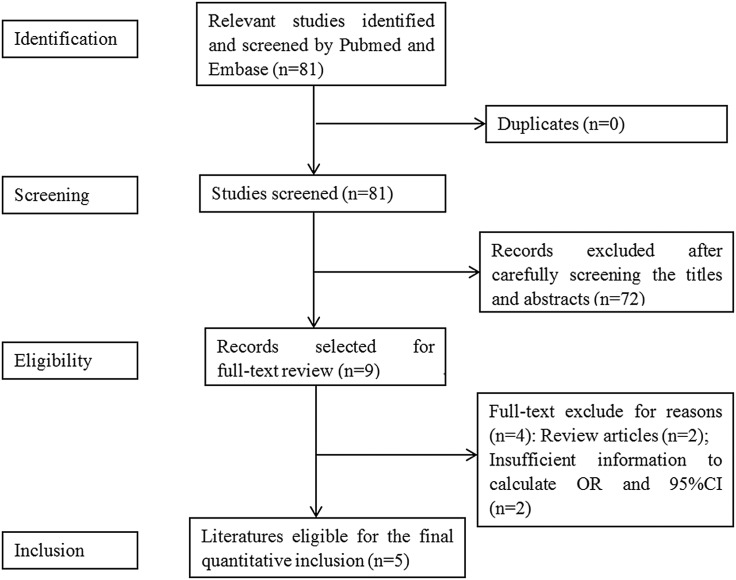
Flow diagram for identification of eligible studies for this meta-analysis.